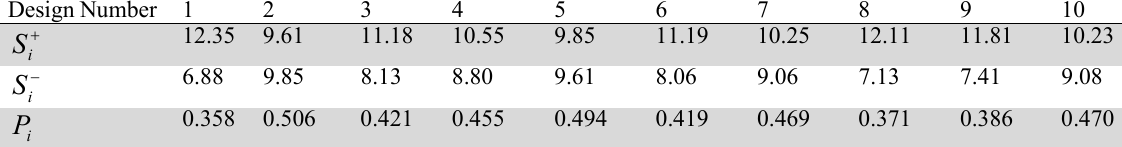
Relative closeness values of each alternative with s-TOPSIS Design Number